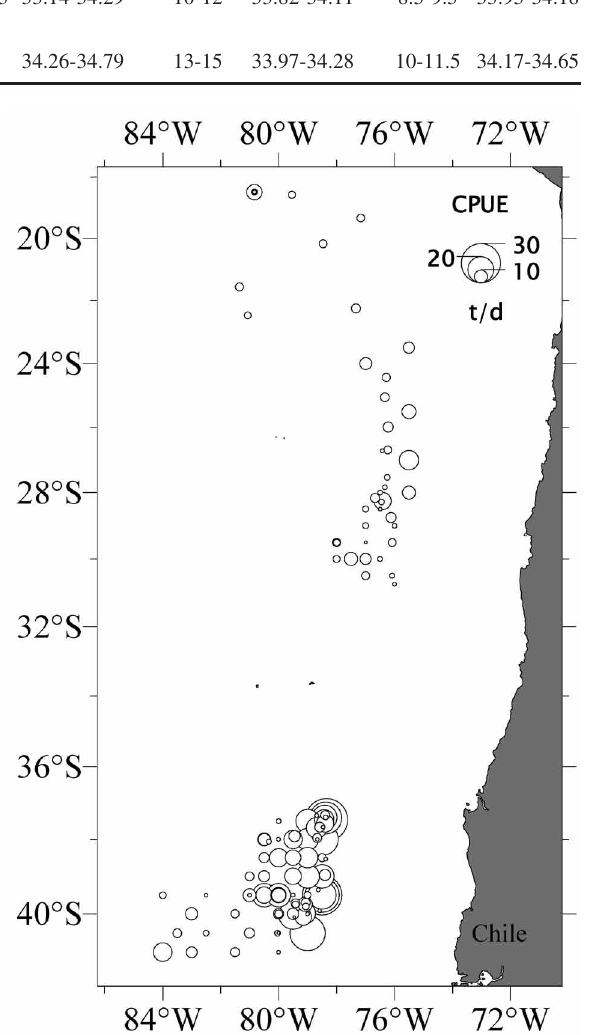
Fig . 2. – Spatial distribution of daily catch of D. gigas in the 0.5°×0.5° latitude and longitude off Chile between April 2006 and May